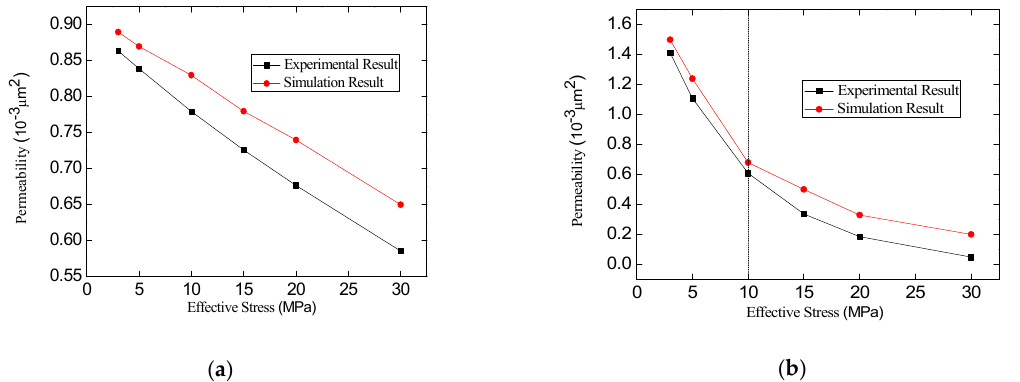
Figure 7. Simulation and experimental results of stress-dependent permeability: ( a ) matrix and ( b ) fractured core.